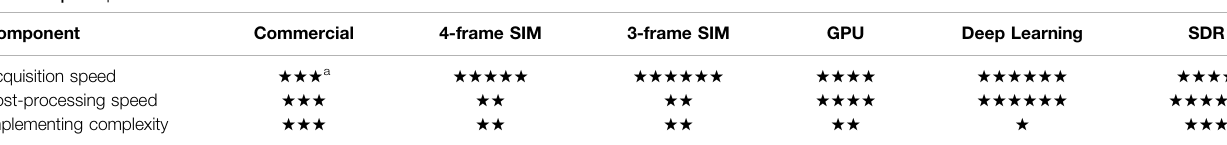
TABLE 2 | Comparison of reconstruction methods for fast